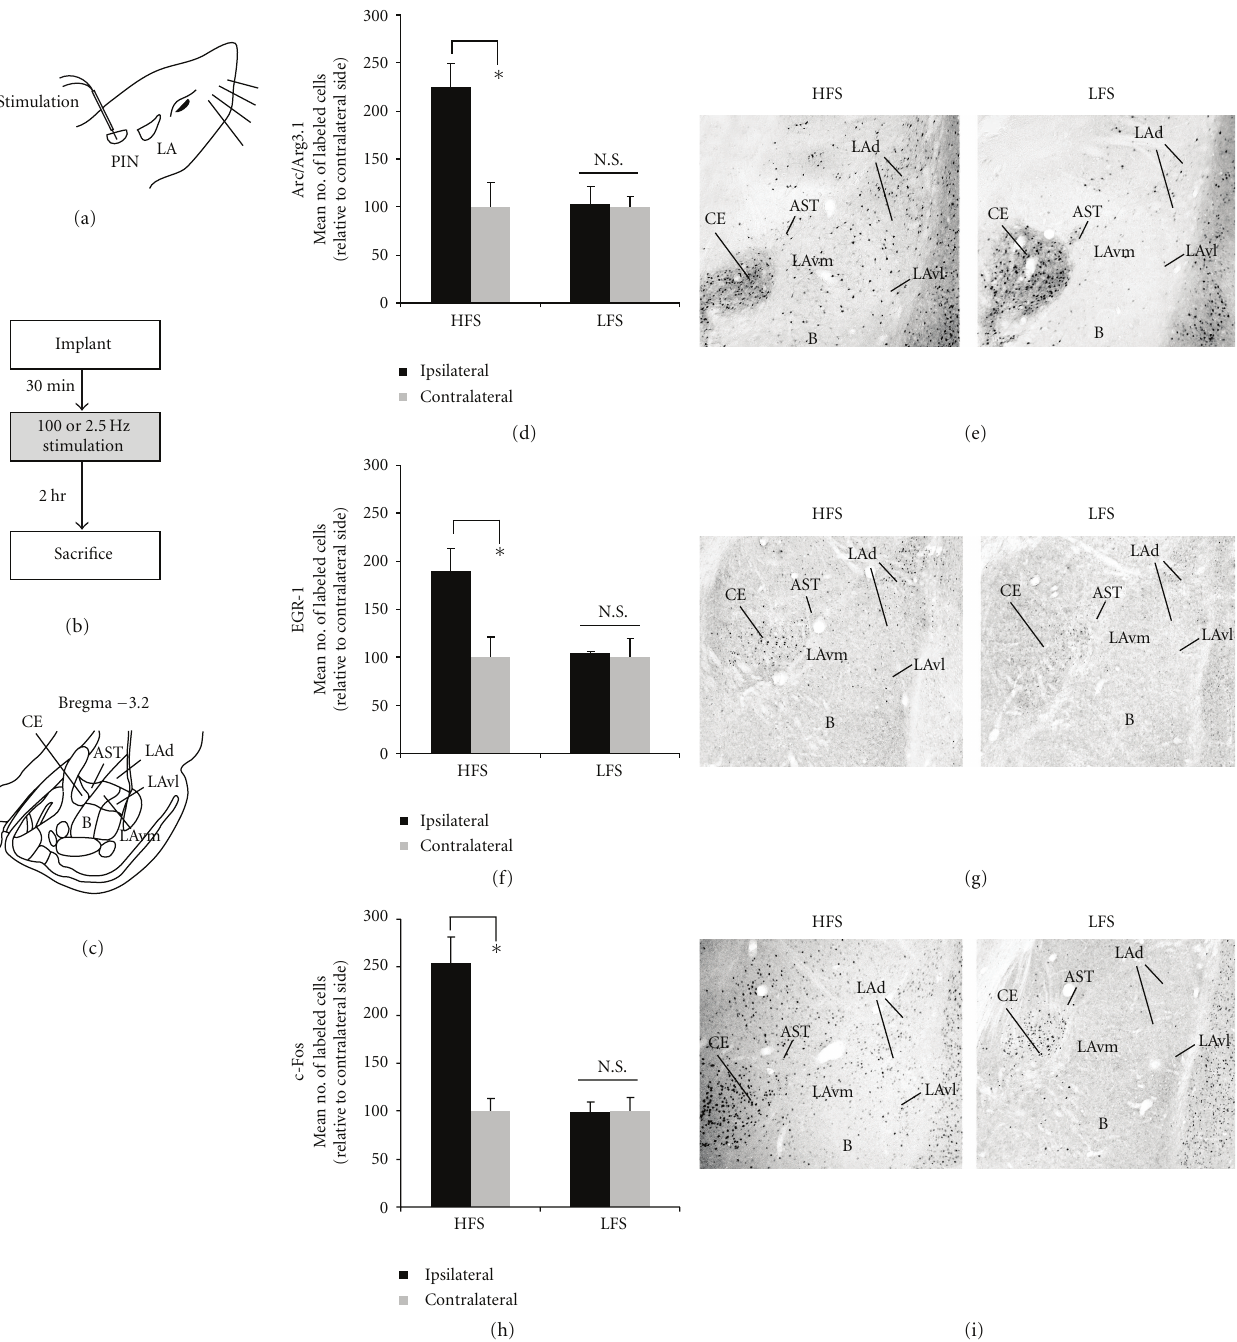
Figure 3: High-frequency stimulation of the MGm/PIN promotes increased immunolabeling of ERK-driven IEGs in the LA (a) Placement of stimulation electrode. (b) Schematic of experimental protocol. Rats were given HFS or LFS and sacrificed 2 hours after stimulation. (c) Schematic of the amygdala at Bregma − 3.2. (d) Mean ( ± SEM) percent Arc/Arg3.1 immunoreactive cells in the LA from rats receiving HFS ( n = 6) or LFS ( n = 6). (e) Photomicrographs showing Arc/Arg3.1-labeled cells from rats receiving HFS (left) or LFS (right). (f) Mean ( ± SEM) percent EGR-1 immunoreactive cells in the LA from rats receiving HFS ( n = 6) or LFS ( n = 6). (g) Photomicrographs showing EGR-1-labeled cells from rats receiving HFS (left) or LFS (right). (h) Mean ( ± SEM) percent c-Fos immunoreactive cells in the LA from rats receiving HFS ( n = 6) or LFS ( n = 6). (i) Photomicrographs showing c-Fos-labeled cells from rats receiving HFS (left) or LFS (right). In each experiment, ipsilateral cell counts have been expressed as a percentage of contralateral cell counts for each rat. ∗ P < . 05 relative to the ipsilateral side N.S. = not significant. LAd = dorsal division of the lateral amygdala; LAv l = ventrolateral division of the lateral amygdala; LAvm = ventromedial division of the lateral amygdala; CE = central amygdala; B = basal amygdala; AST = amygdala-striatal transition